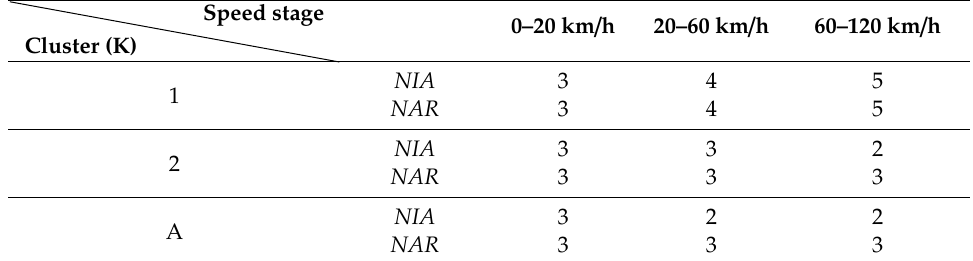
Table 6. Values of number of initial anchors ( NIA ) and number of aspect ratios ( NAR ).